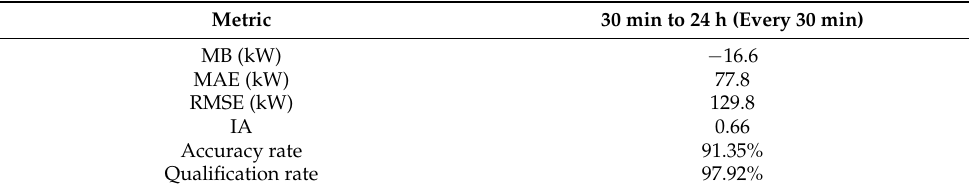
Table 20. Evaluation results of the multi-hour ahead wind power forecasting system applied to the 4-day test dataset.